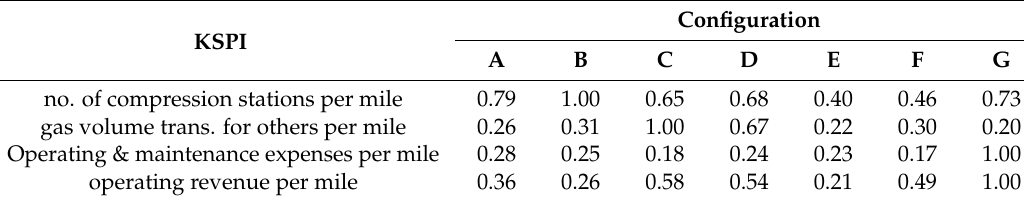
Table 7. Means of KSPIs measurements relative to sample configurations.